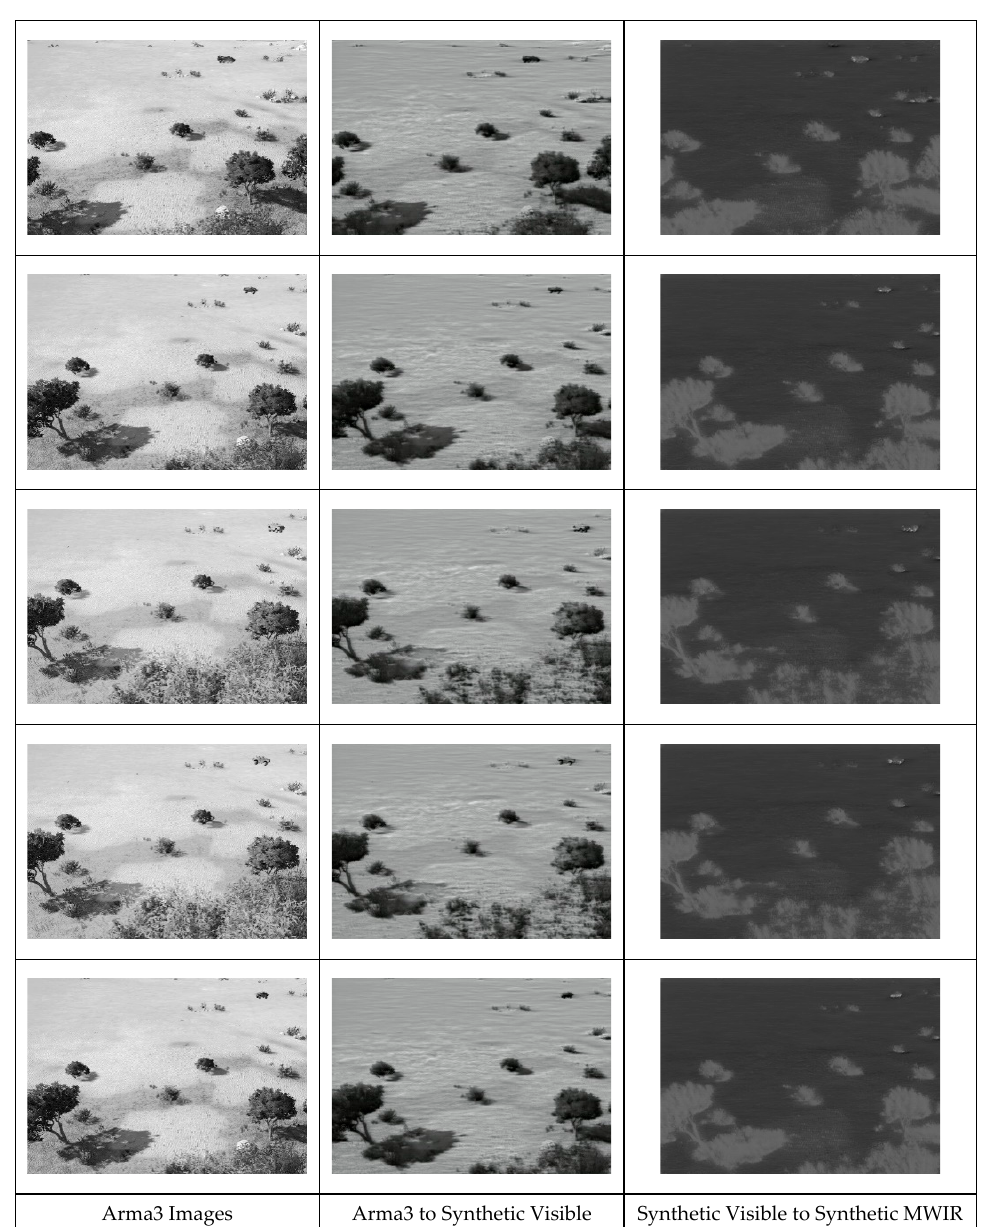
Figure 6. MWIR images generated from game-engine-generated synthetic images using our tech- nique. Table 3. Quantitative evaluation of the translation from game-engine-generated images to MWIR images.